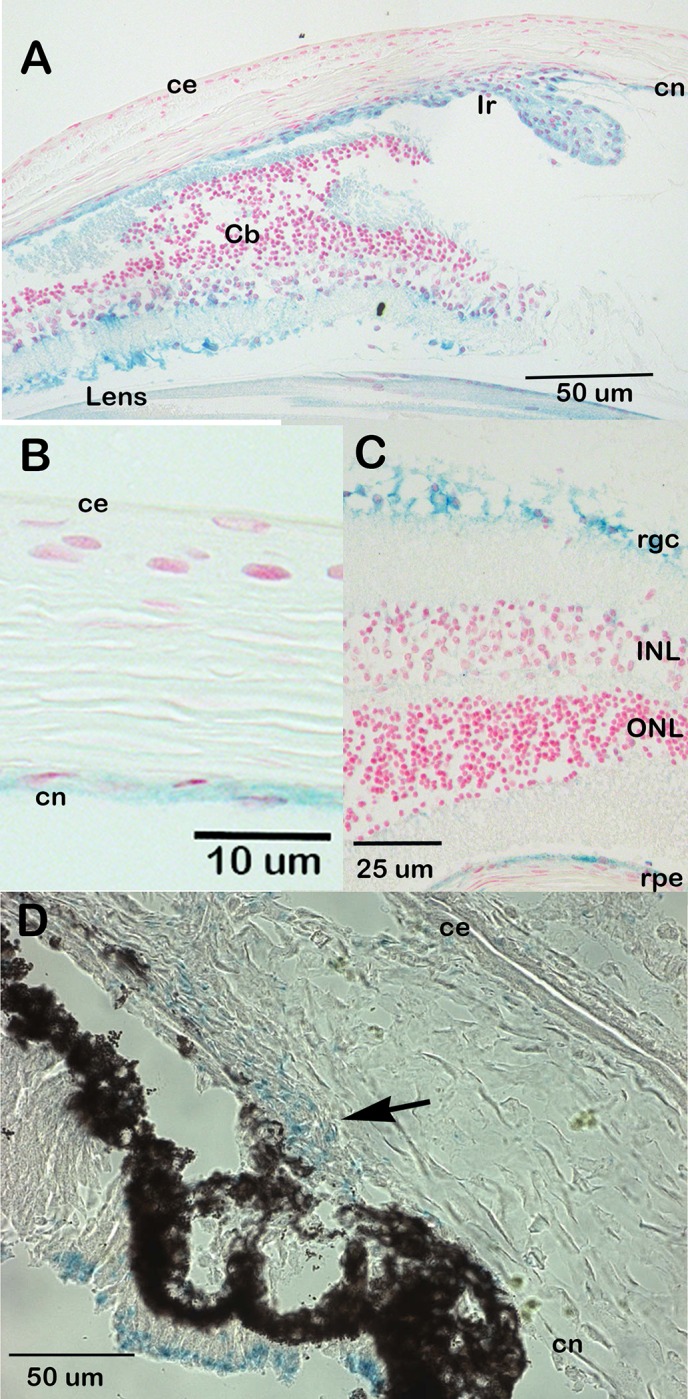
Expression of Csrp2bp in the eye.Blue staining represents Csrp2bp expression. (A) Adult (3 months) iridocorneal angle, B6/albino background. ce, corneal epithelium; cn, corneal endothelium; Ir, iris; Cb, ciliary body. (B) Adult central cornea (B6/albino) (C) Retina (B6/albino). rgc, retinal ganglion cells; ONL, outer nuclear layer; INL, inner nuclear layer; rpe, retinal pigment epithelium. (D) Neonatal (P0) iridocorneal angle (B6). The arrow points to the developing iridocorneal angle.